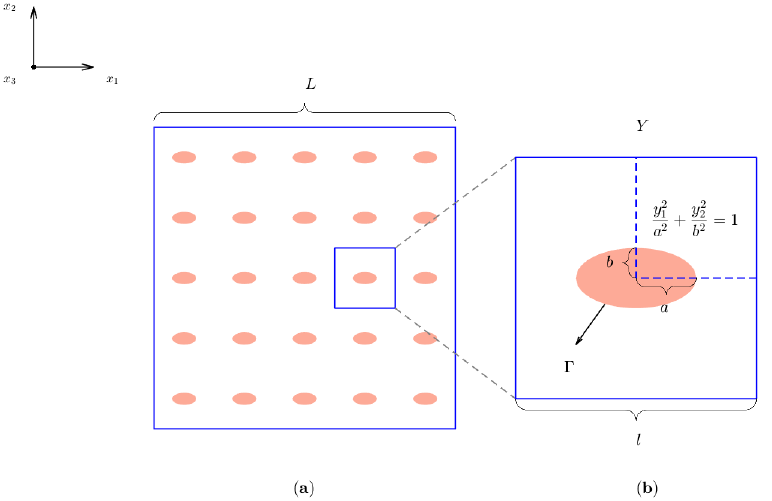
Figure 9. ( a ) Material composed of fibers with an elliptical cross section, ( b ) periodic cell Y